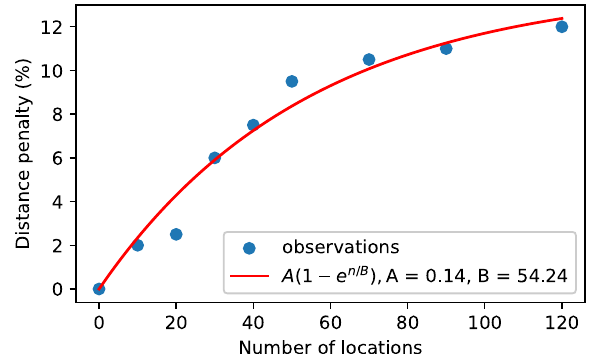
Fig. 7 An empirical model of human performance on the TSP, taken from Dry ’ s review 20 . The individual observations from that work are reproduced here; a curve fi t of the form p ( n ) = A (1 − e n / B ) was performed to yield a smooth model for the penalty p ( n ). The penalty is <10% for problems sized up to around 60